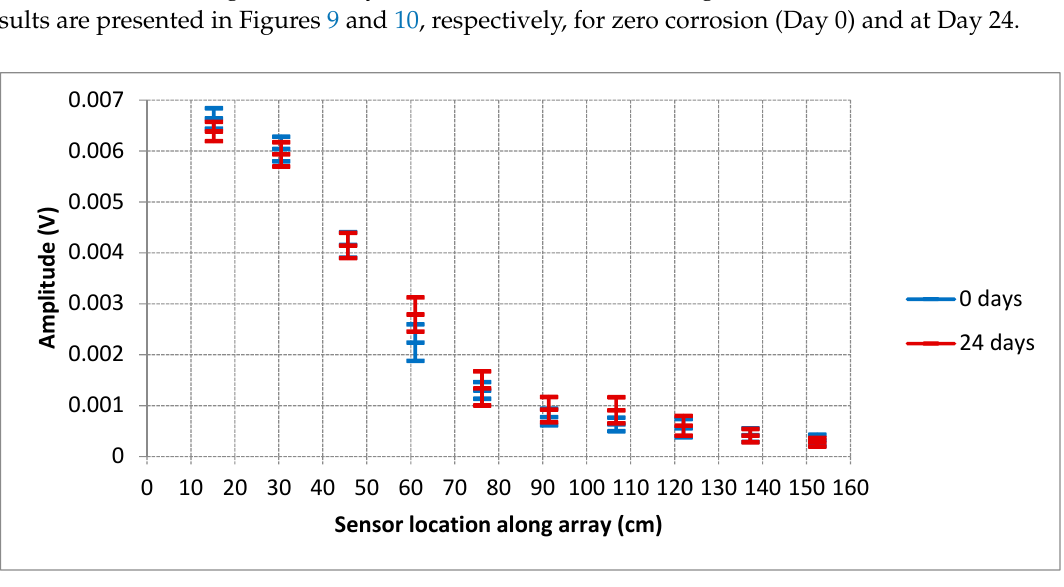
Figure 9. Amplitude of leaked waves versus sensor location plot for Specimen 1, with the transmitter on the corroded bar (Rebar 1: corrosion in the middle) and receivers 30.48 cm (1 foot) away from the bar.